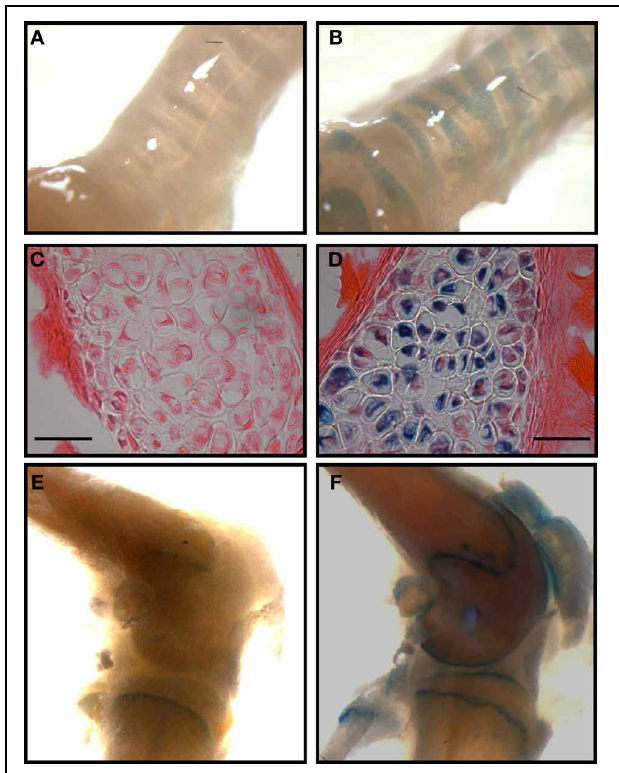
articular surface of the knee. (A,B) are images of whole trachea stained with X-gal in wild type and heterozygous TASK-2 ( + / − ) mice, respectively. The signal is present in the cartilage rings. In (D) the image demonstrates staining in chondrocytes [ (C) : wild-type control]. (E,F) : images obtained from control and heterozygous TASK-2 ( + / − ) mouse knees. The macroscopic staining in the area of the epiphyseal growth plate observed in WT knee corresponds to cells that are expressing endogenous mammalian ß-gal activity, most likely osteoclasts (Kopp et al., 2007). Bars in (C,D) correspond to 25 μ